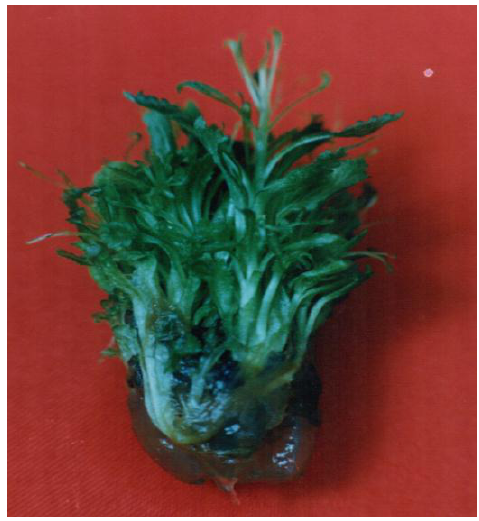
Figure 1 : Multiplication shoot tip of Digitalis purpurea (Var. excelsior Mixed) in the treatment 0.5 mg/L TDZ and 2.0 mg/L cholesterol after 45